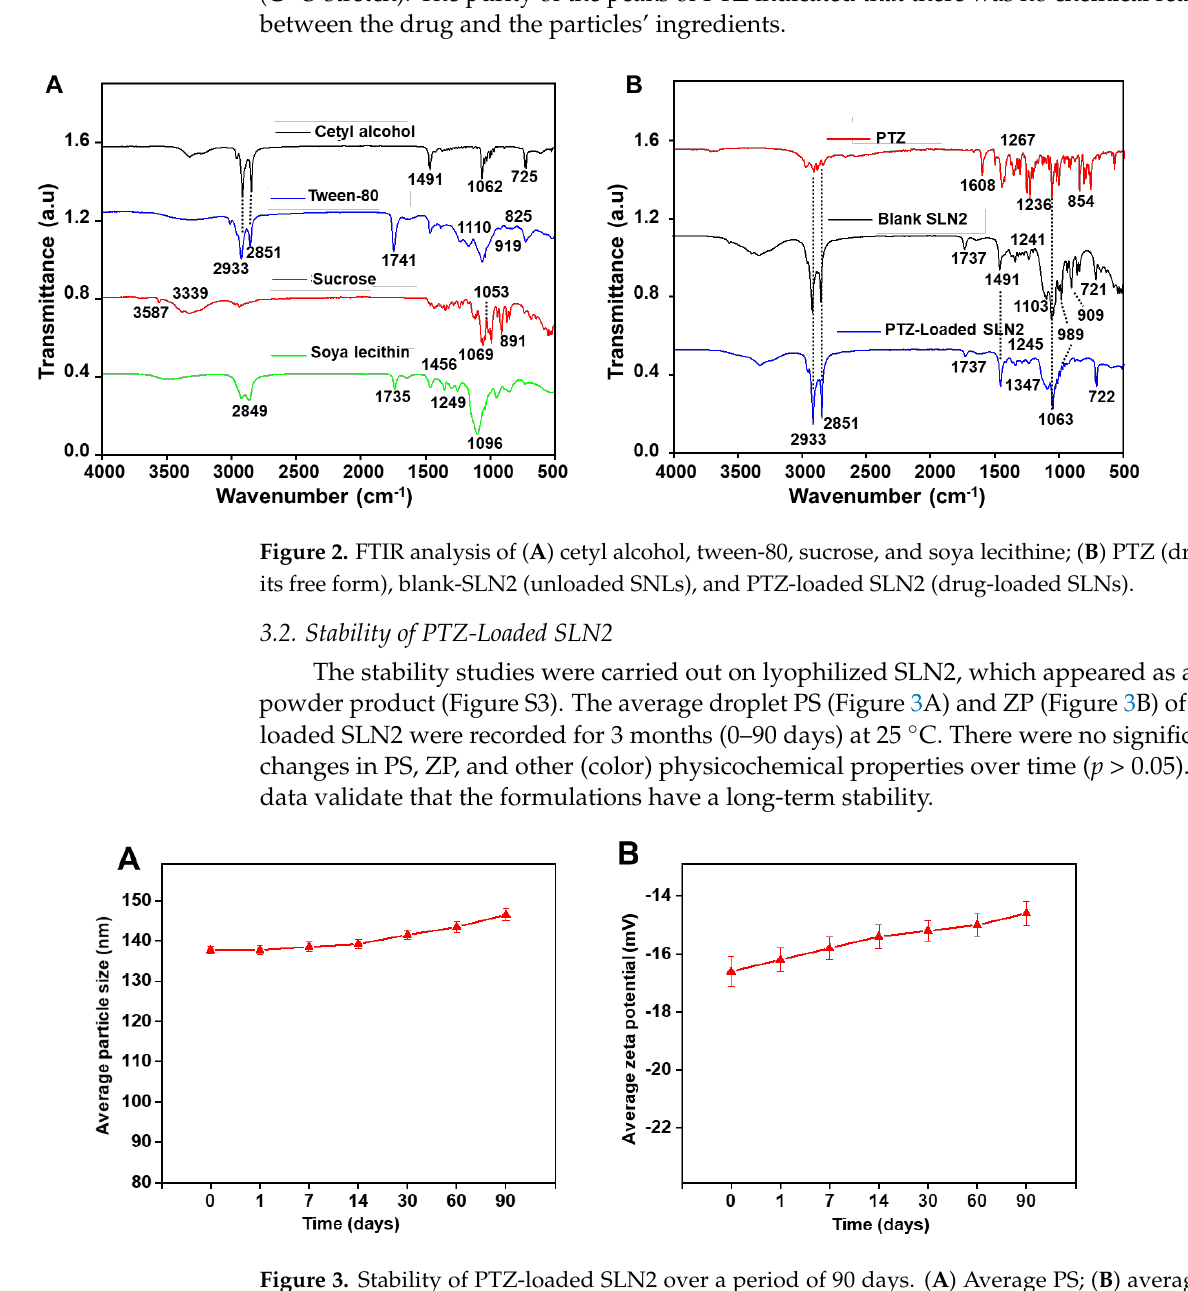
Figure 3. Stability of PTZ-loaded SLN2 over a period of 90 days. ( A ) Average PS; ( B ) average ZP, measured by DLS. Data are expressed as mean ± SD (n = 3). No significant differences were observed in PS and ZP over time ( p > 0.05).